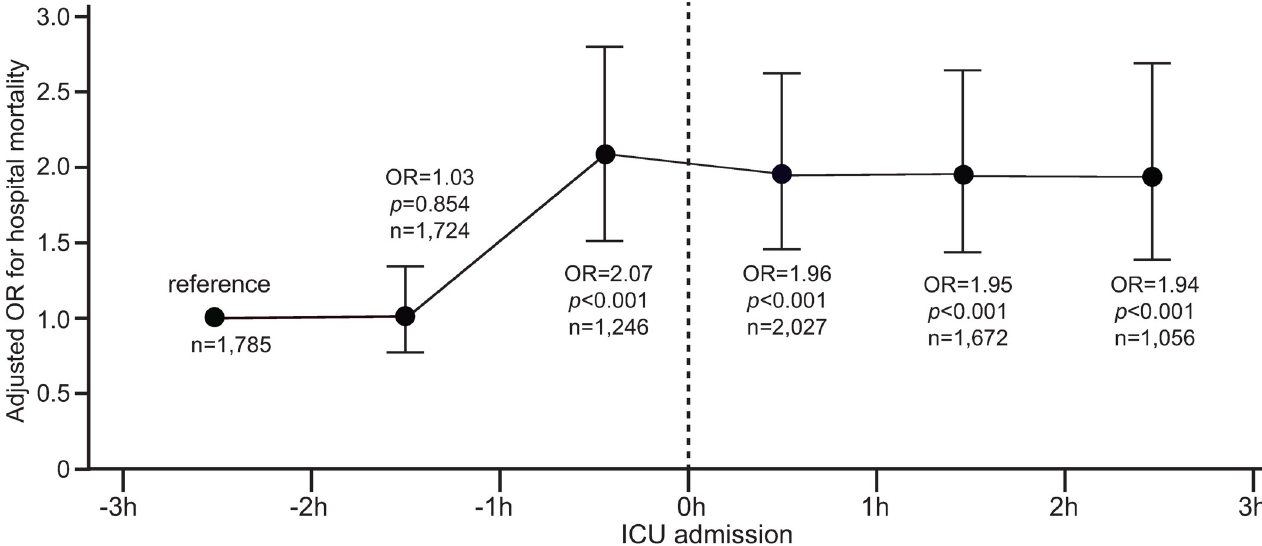
Fig 4. Subgroup analysis of adjusted OR for hospital mortality during each time-window for lactate measures in the PSM cohort (n = 9,510). OR was adjusted for age, gender, ethnicity, ICU type, admission type, ICU severity scores, CCI, and initial lactate level. Error bars represent 95% confidence intervals.